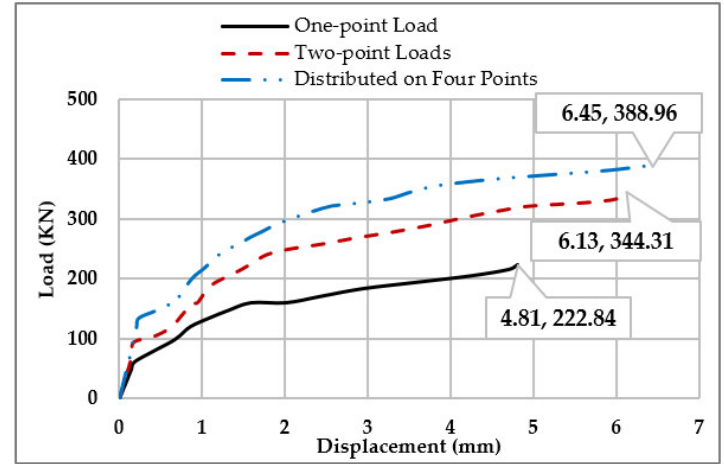
Figure 10. Load-Displacement Curves for Group (3).